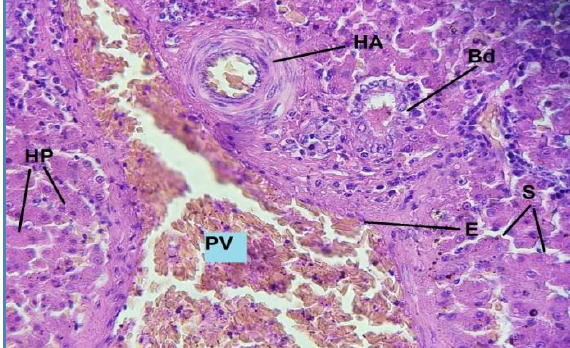
Figure, 14: Histological section of the liver in gull shows, the portal triad. Portal vein (PV), hepatic artery (HA), bile duct (Bd) and sinusoids (S), hepatic plate (HP), endothelial cells of portal vein (E) (H and E